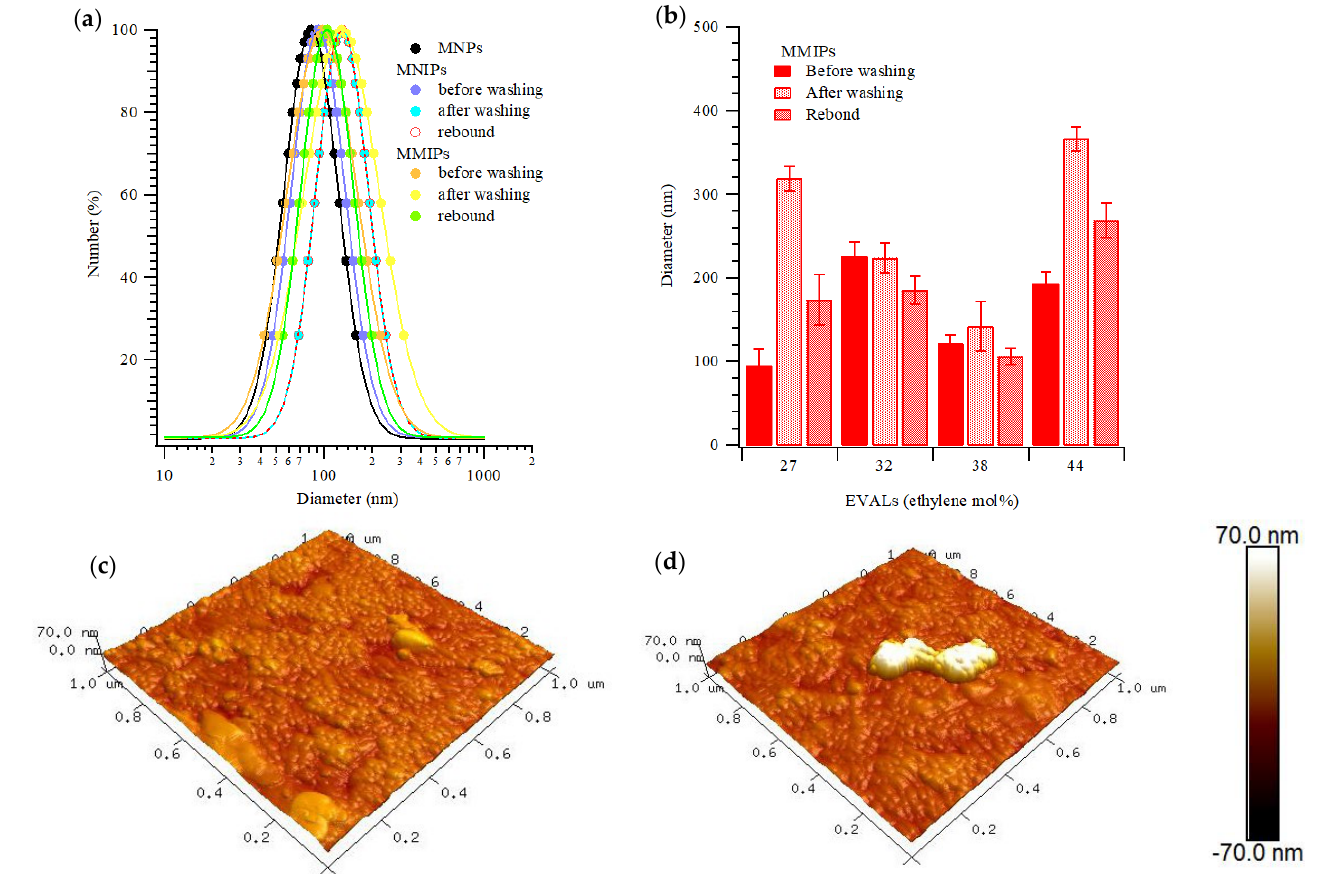
Figure 1. ( a ) DLS size distributions of magnetic non- and peptide-imprinted composite nanoparticles before and after peptide removal and rebinding. ( b ) Mean sizes of nanoparticles prepared with EVALs with various ethylene mol%. AFM images of magnetic ( c ) non- and ( d ) peptide-imprinted composite nanoparticles after peptide removal.